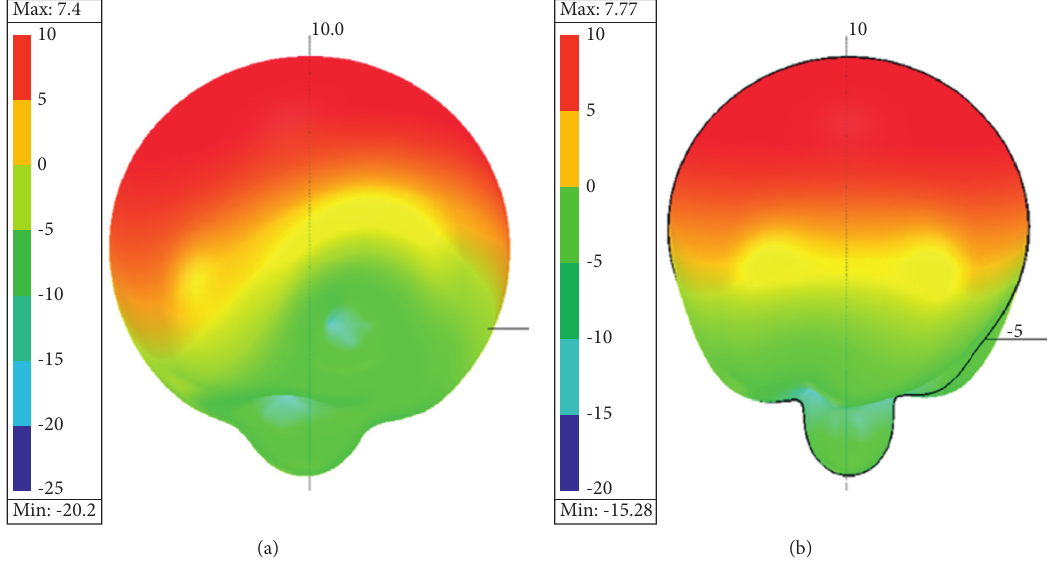
Figure 6: Comparison of simulated total gain radiation patterns in dB at 2.25GHz: (a) before and (b) after